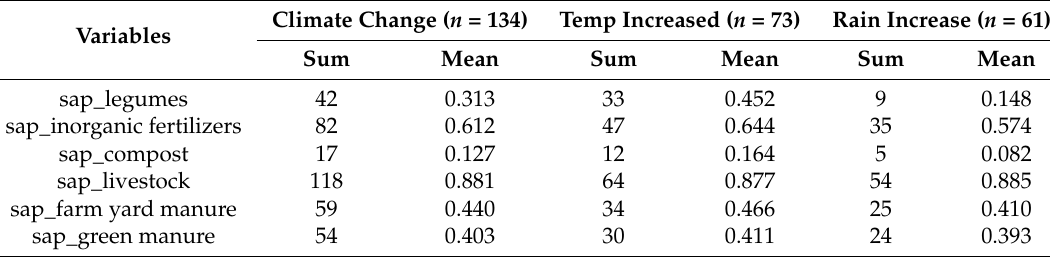
Table 2. Descriptive statistics by perceptions on climate change.